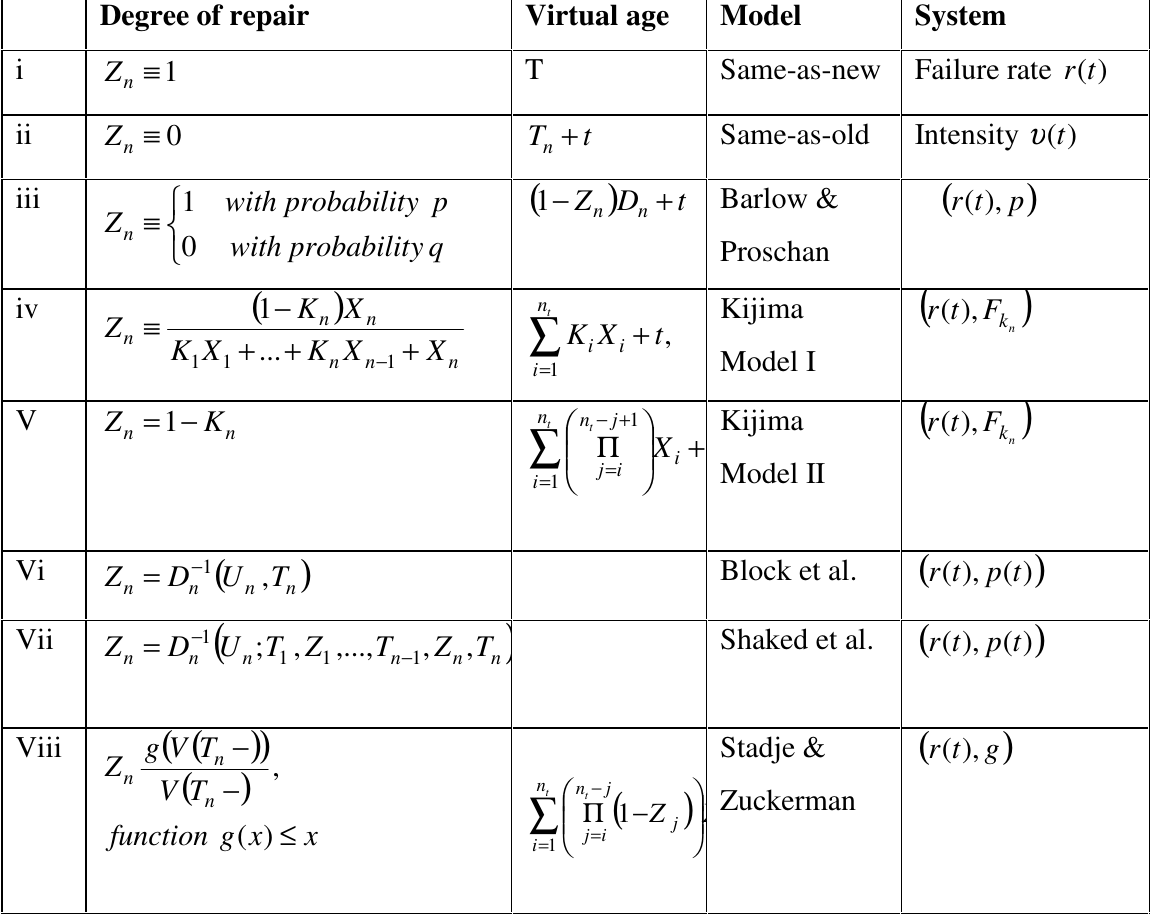
Table 5: Virtual age models covered by virtual age